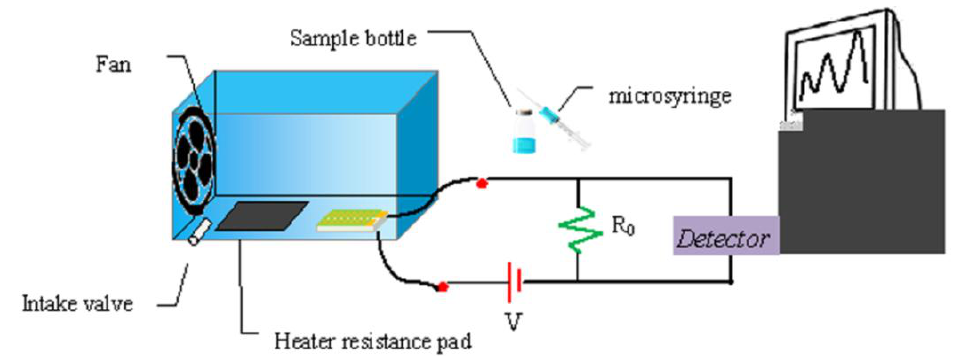
Figure 3. Schematic illustration of lab-made sensing